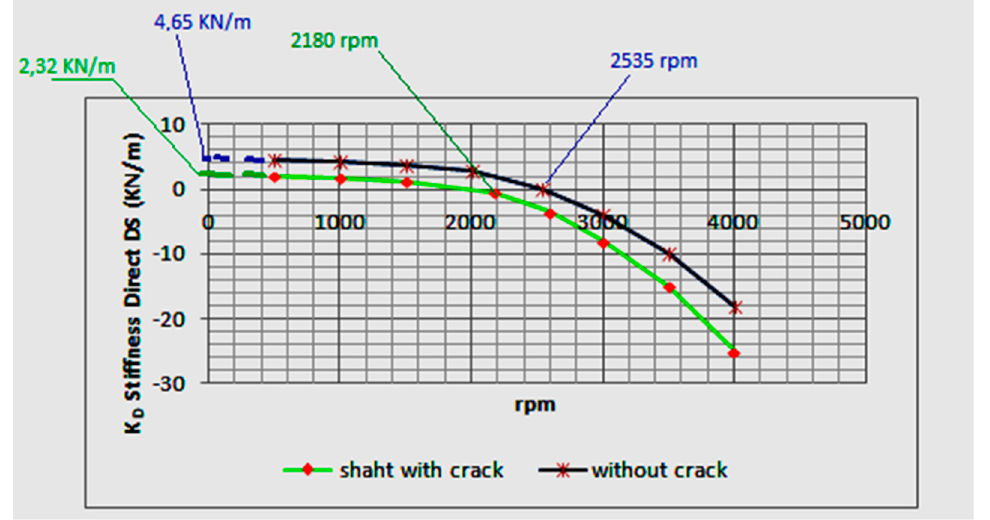
Figure 5. Dynamic